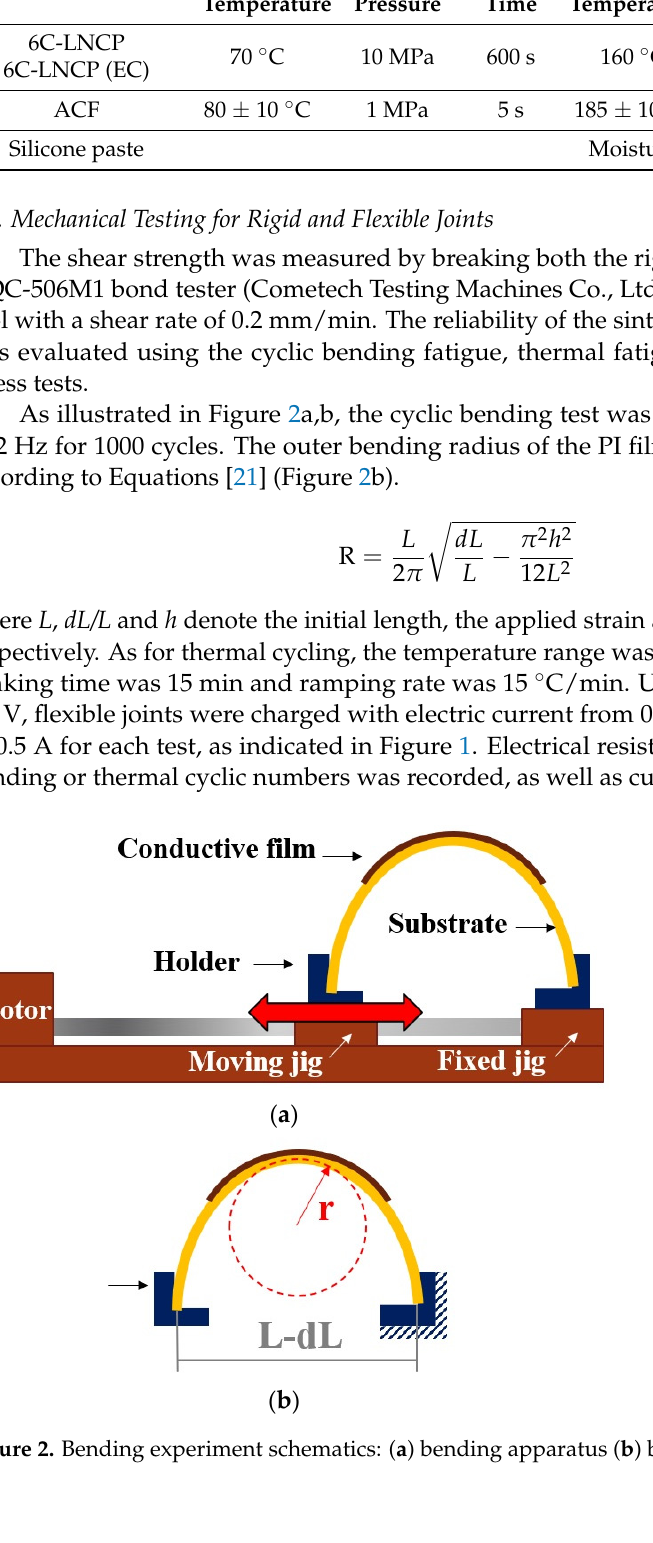
Table 1. Processing conditions for bonding.